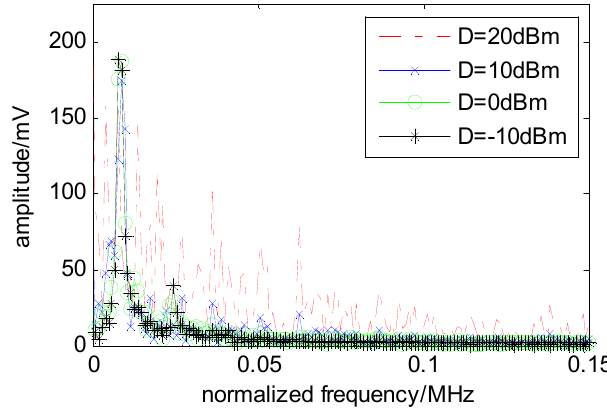
Table 1. Critical coupling points of different noise variances (